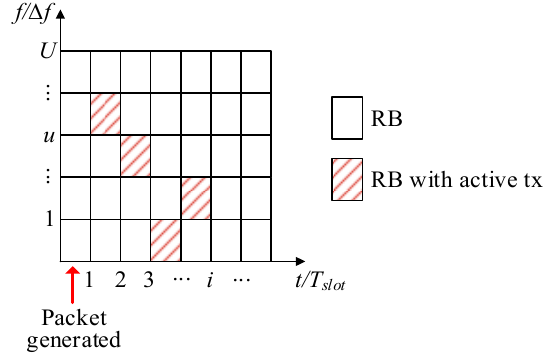
Figure 1. Illustration of the Fifth Generation New Radio (5G NR) resource grid map: Transmission of a data packet with four repetitions and a random selection of Resource Blocks (RBs) per slot.